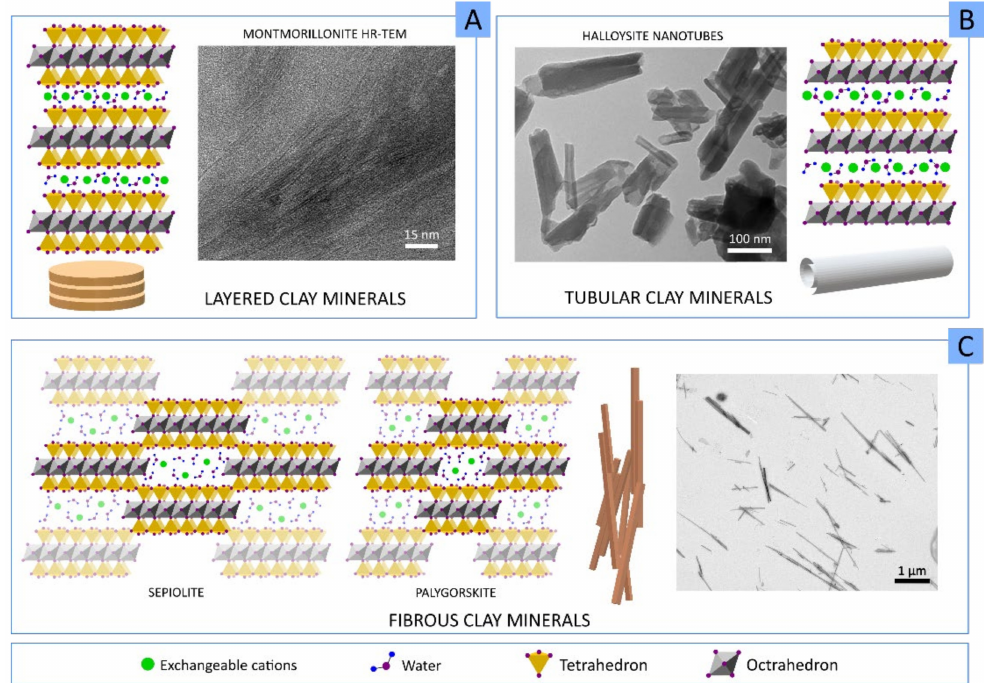
Figure 2. Structure and microphotographs of ( A ) layered clay minerals, ( B ) tubular clay minerals and ( C ) fibrous clay minerals. The SEM microphotograph of halloysite nanotubes ( B ) was adapted with permission from [12], Elsevier,